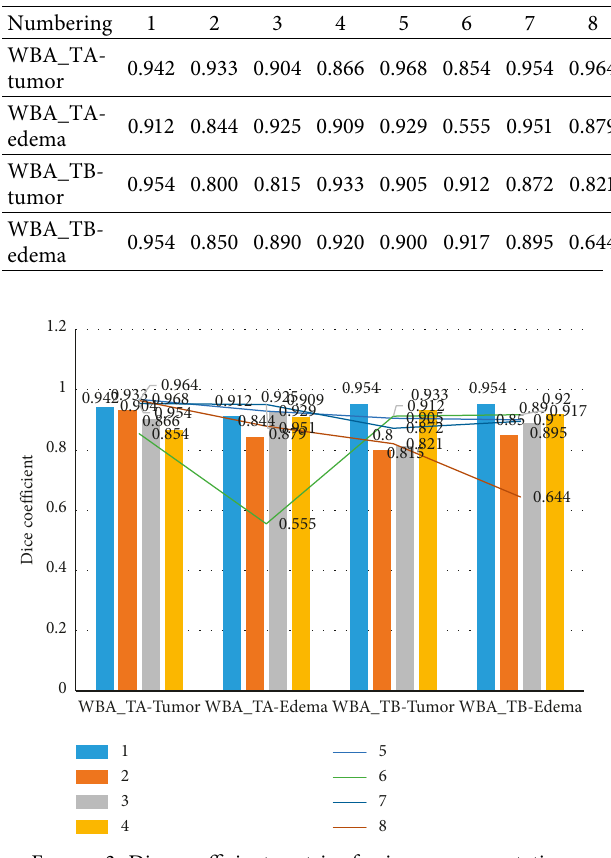
Table 1: Dice coefficient metrics for image segmentation.